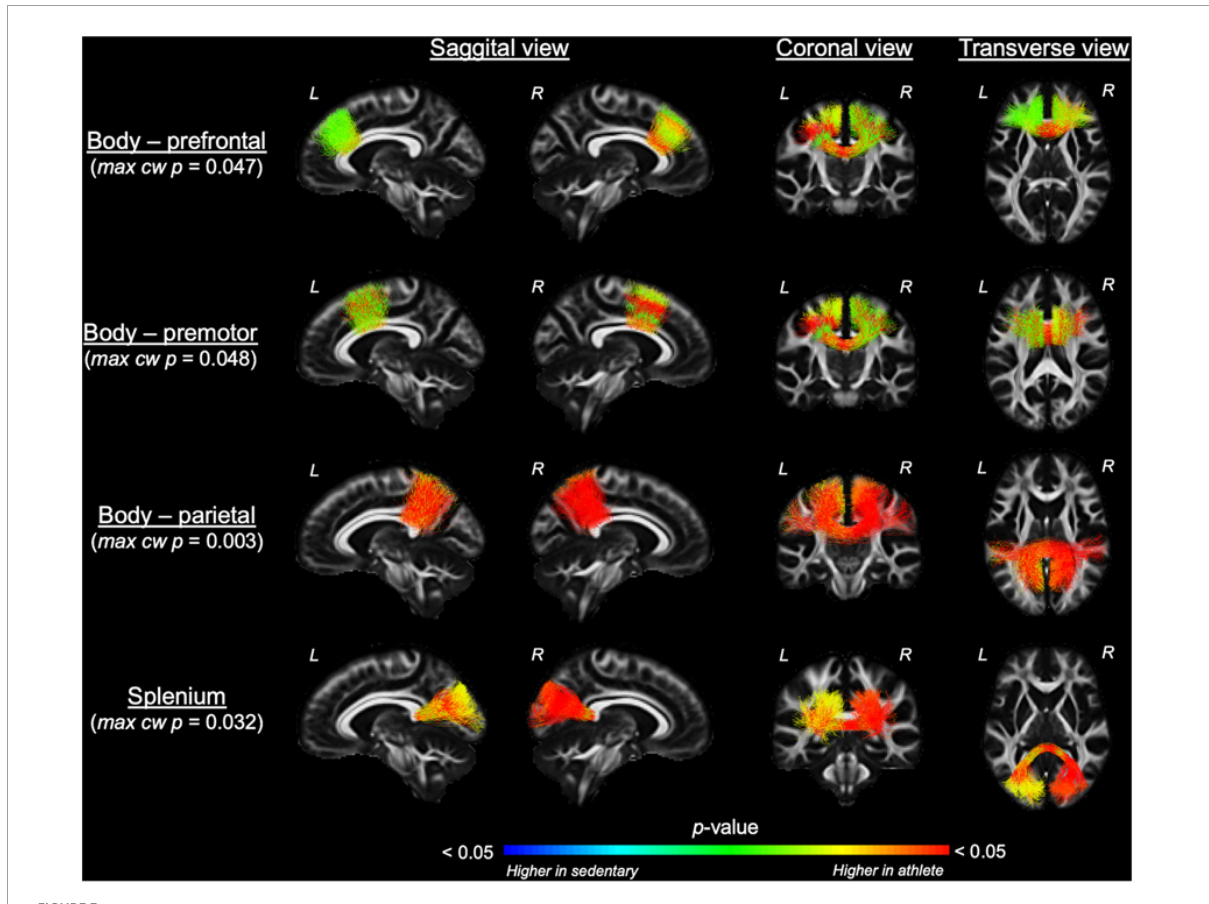
FIGURE3 Along-tract fractional anisotropy (FA) analysis of the corpus callosum compared between the athlete and sedentary groups. Results from general linear model analysis were embedded into the template tract files and displayed in the MGH_HCP_FA_template brain. The maximal, along-tract cluster-wise p -values are presented. L and R denote the right and left hemispheres.